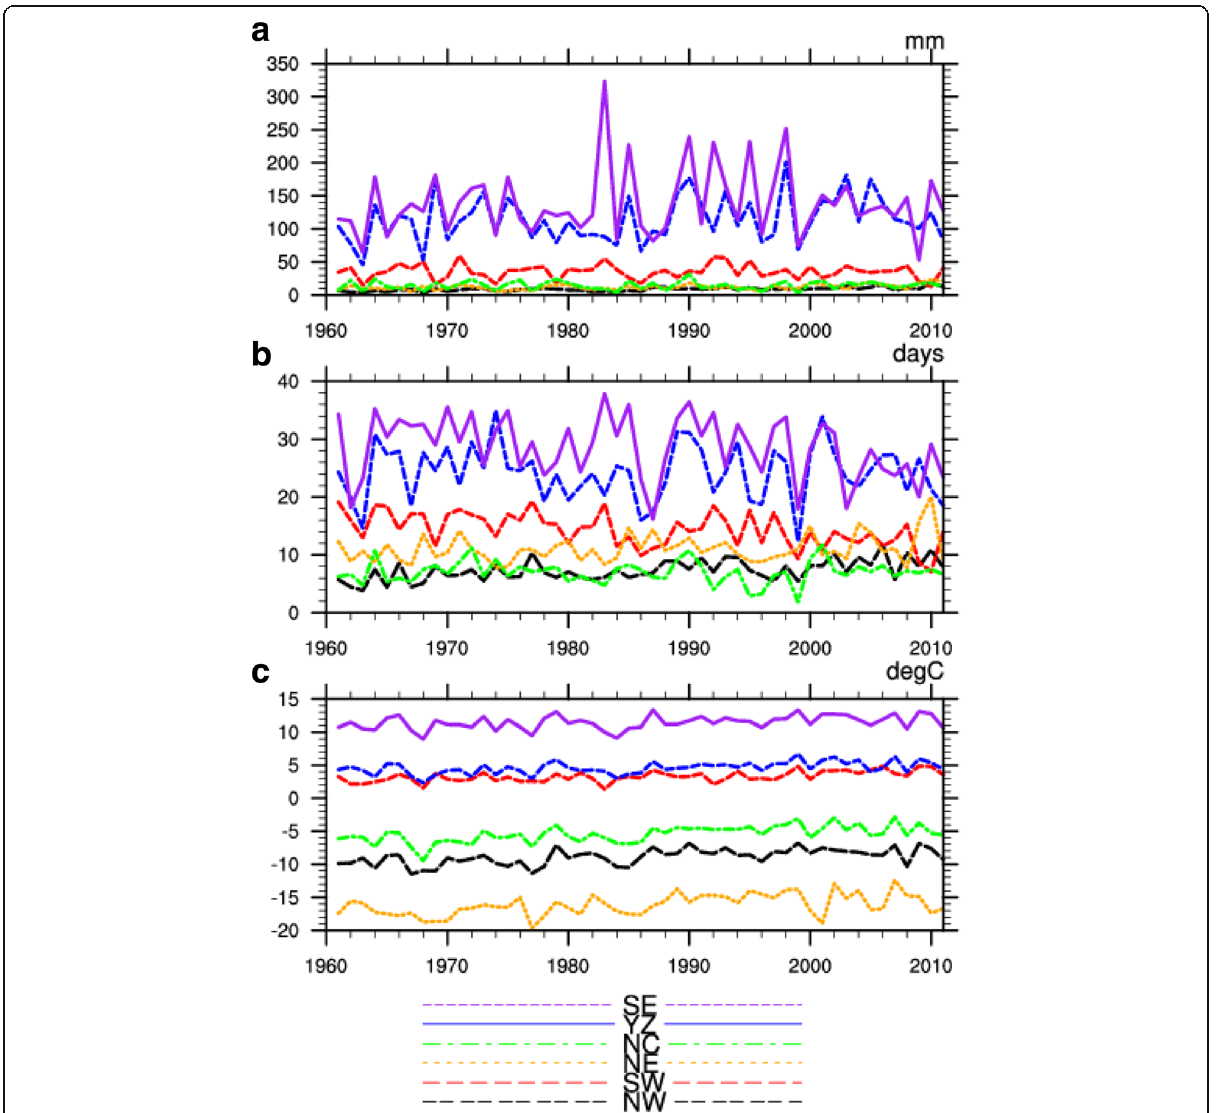
Fig. 2 Subregional climate changes from 1961 to 2011 in winter a rainfall amount, b rainfall days, and c